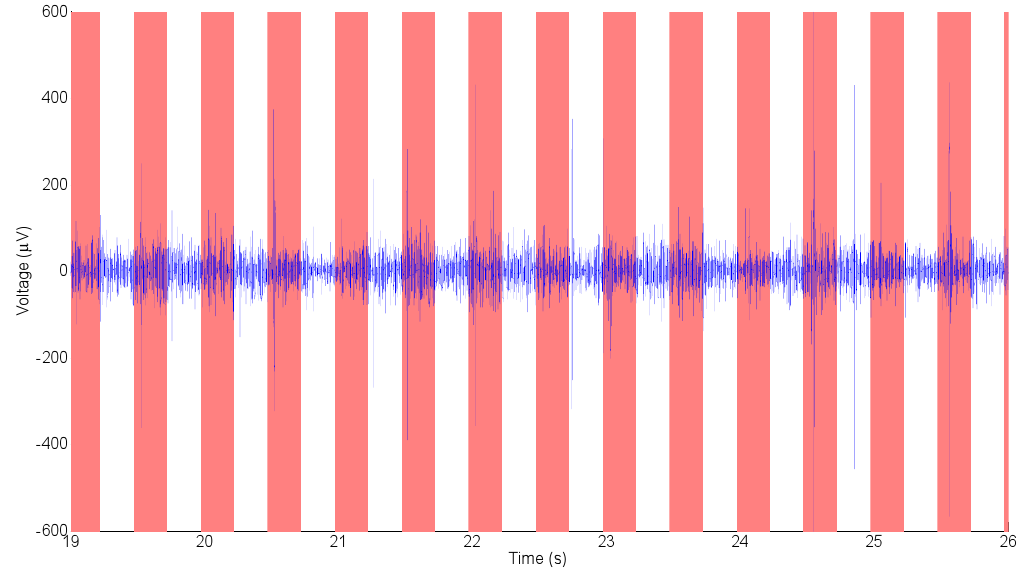
Figure 6. Neural recording from the audio cortex of a guinea pig taken with an all-diamond SMM neural probe, the red bars indicate where auditory stimulus was applied.